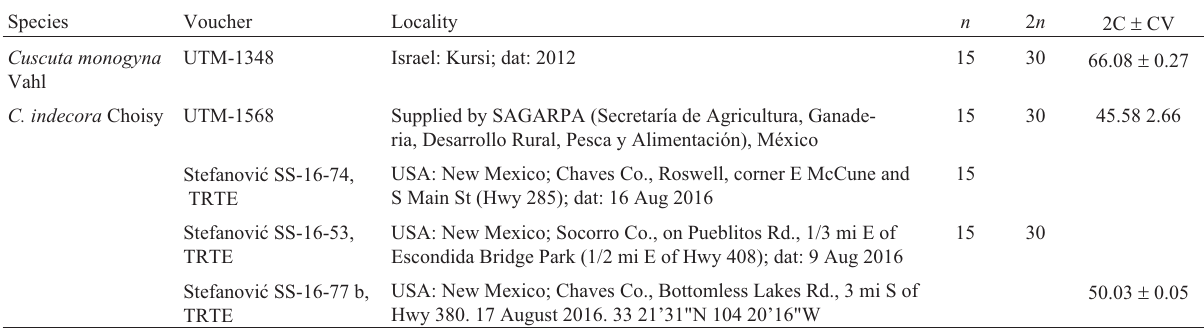
Table 1 - Samples of Cuscuta monogyna and C. indecora investigated, with respective voucher, collection locality, chromosome number observed in meiosis (n) or mitosis (2n), and genome size (2C). Species